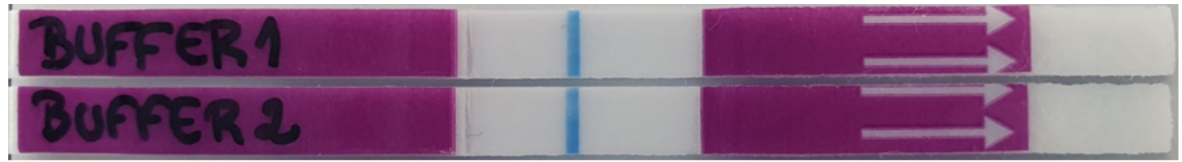
Figure 2. LF strips optimization. Selection of the running buffer. “Buffer 1” = TBS; “Buffer 2” = TBS + tween 20 (0.05% v/v ).